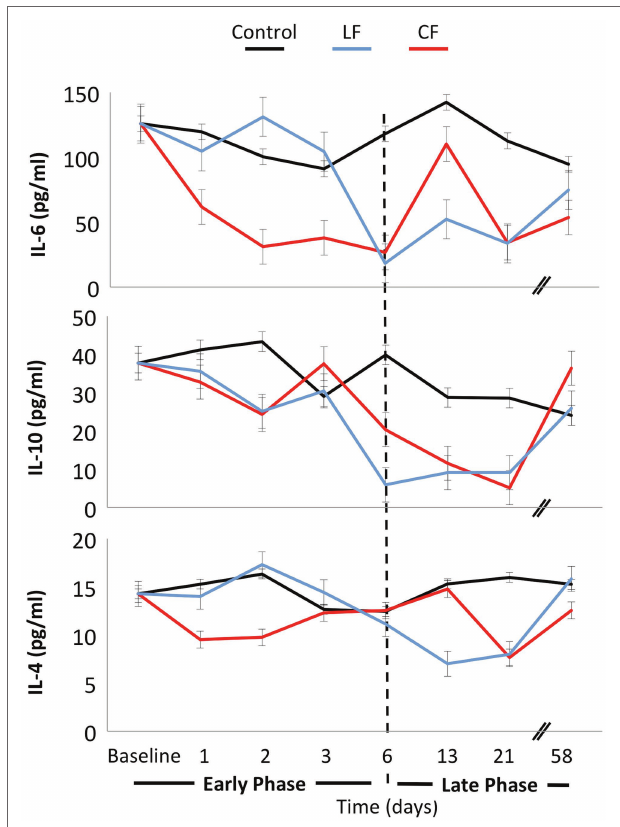
FIGURE 5 | No significant fluctuations of the cytokines IL-4, IL-6, and IL-10 were found over time, and the application of force did not influence these inflammatory